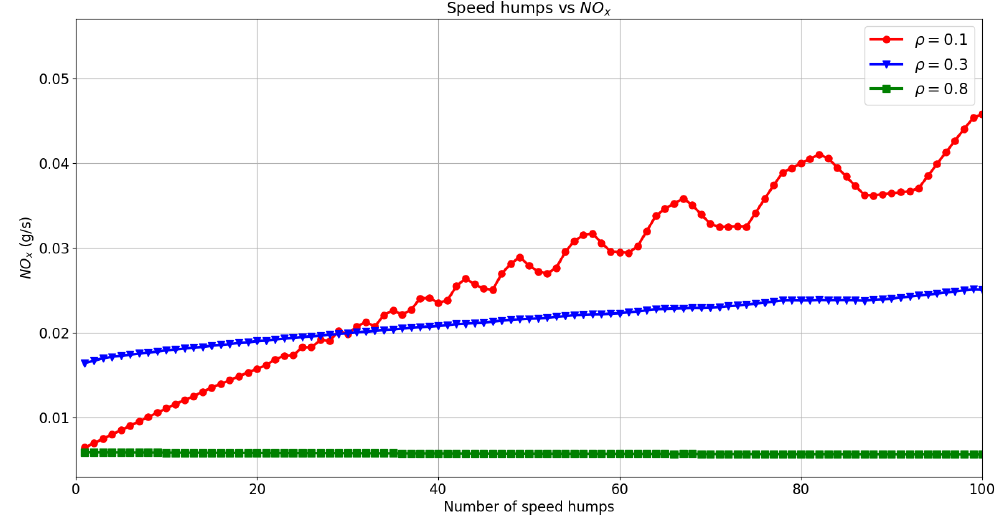
Figure 10. NO x instant emissions as a function of the number of speed